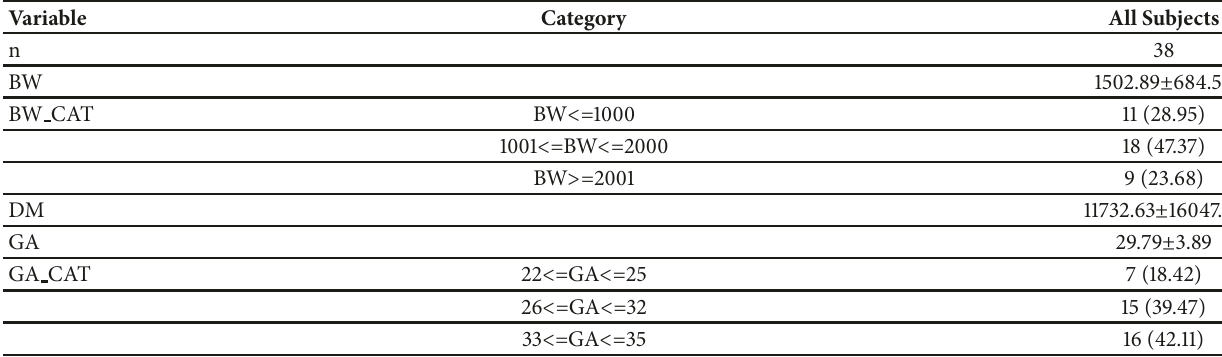
Table 2: Clinical subjects characteristics.